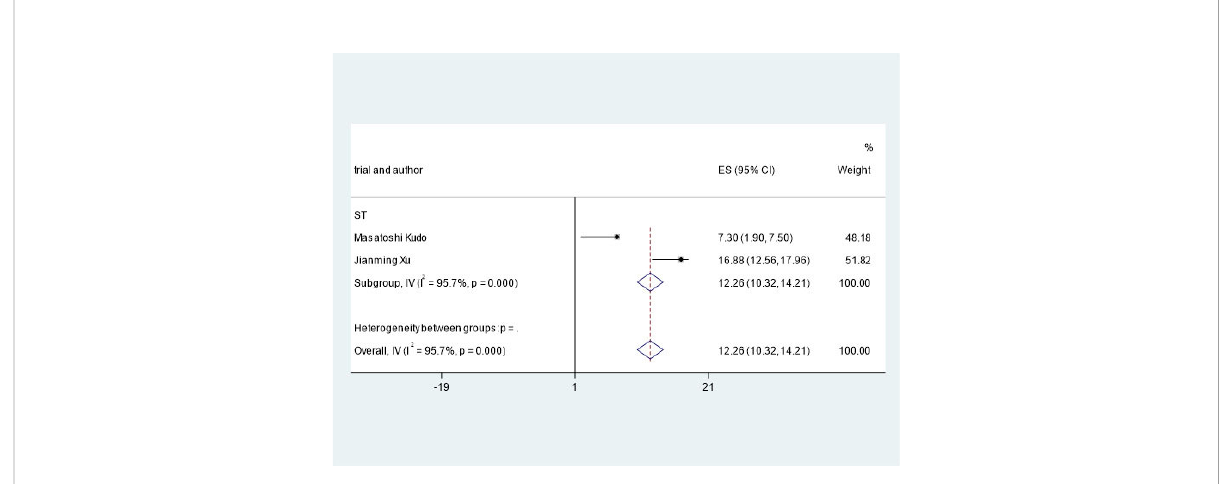
FIGURE 7 Pooled analysis of DOR in patients with HCC treated with immune checkpoint inhibitors combined with antiangiogenic drugs.